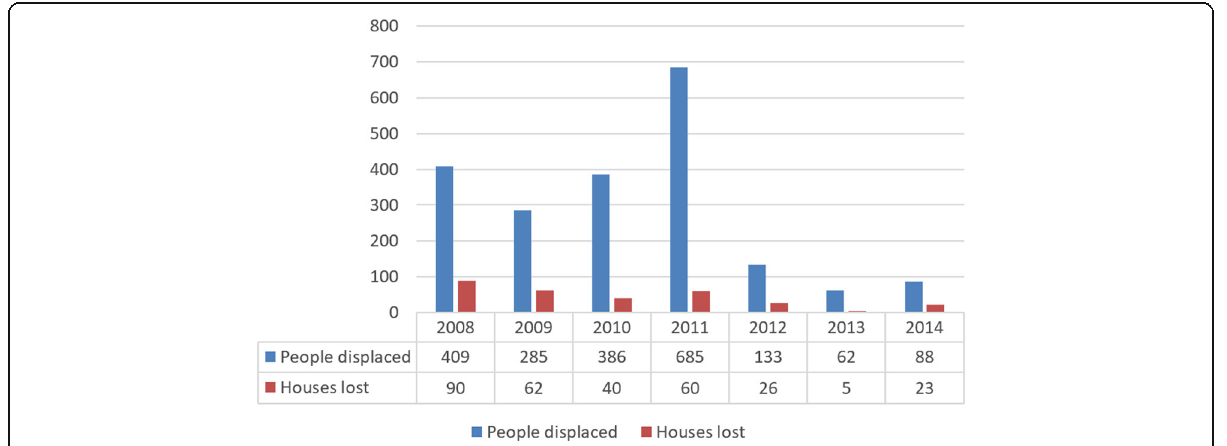
Fig. 2 The number of people affected and buildings destroyed in Keta area between 2008 and 2014 (Data source: NADMO